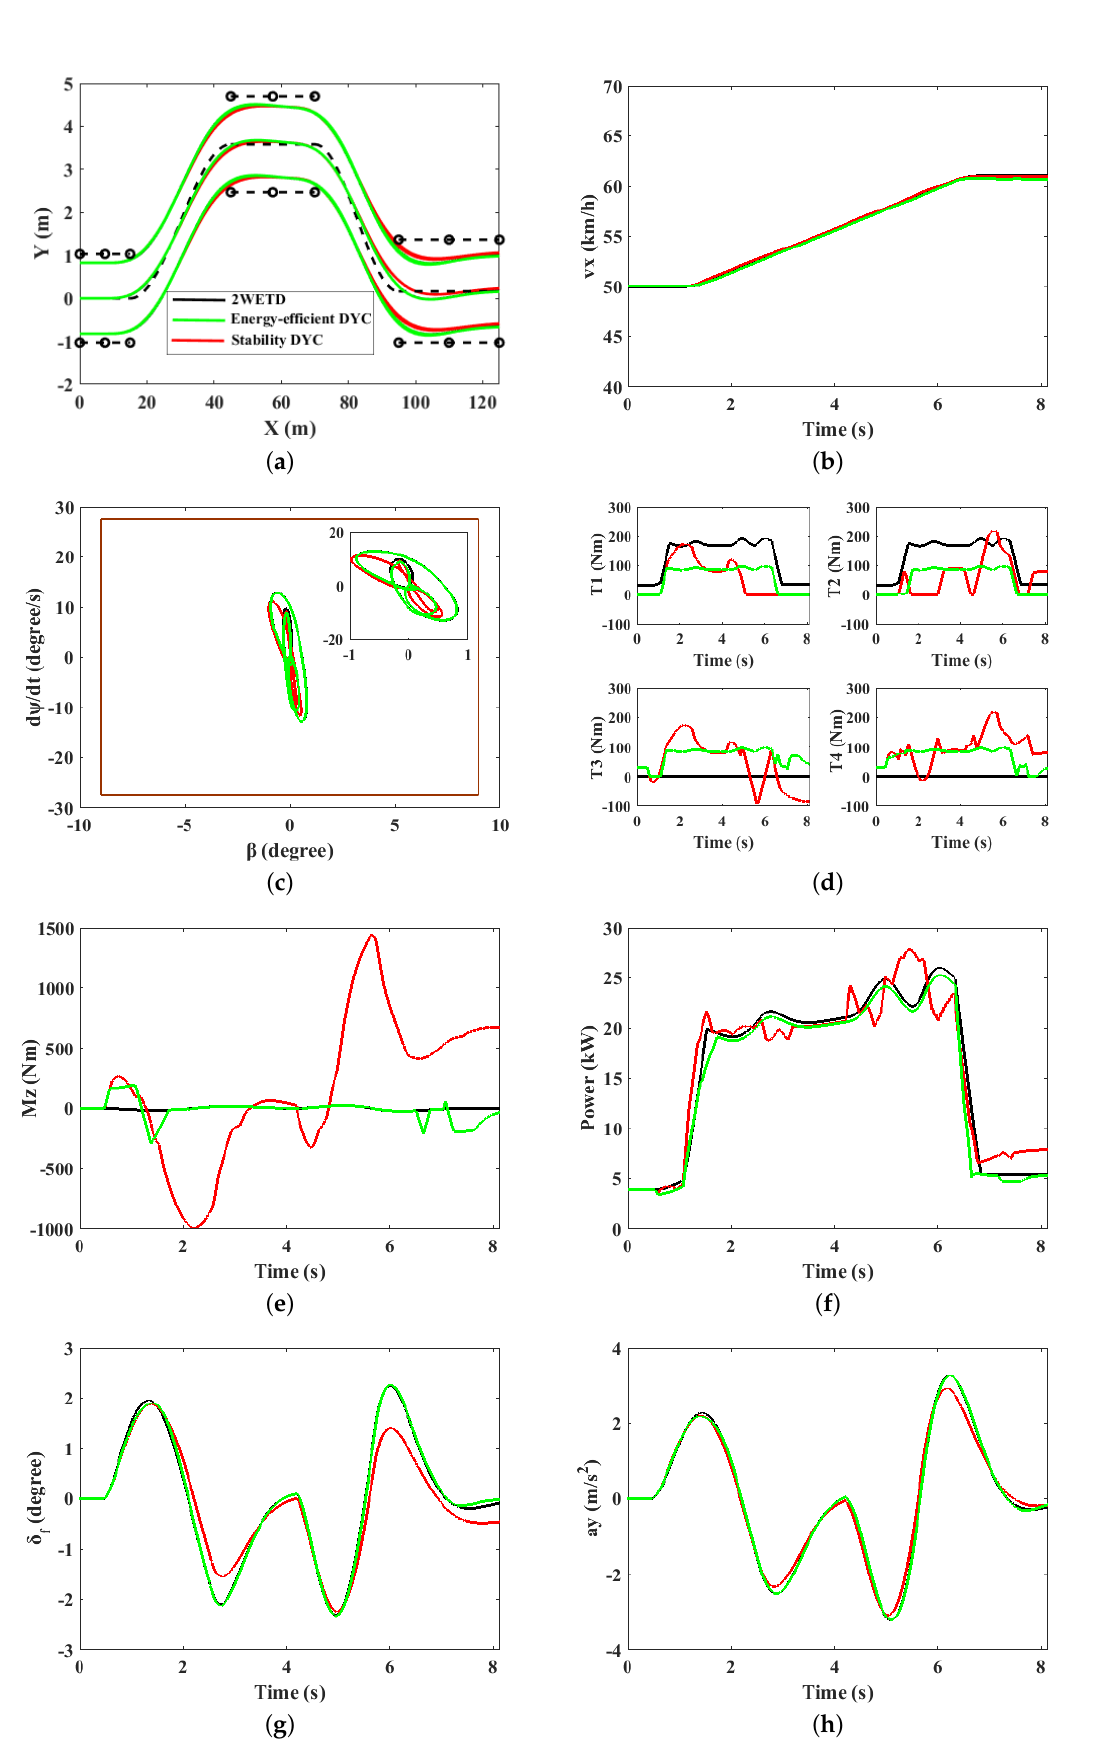
Figure 18. Acceleration during cornering with Motor II ( a ) Path; ( b ) Longitudinal velocity; ( c ) Working area; ( d ) Wheel torques; ( e ) Yaw moment; ( f ) Power; ( g ) Front steering angle; ( h ) Lateral